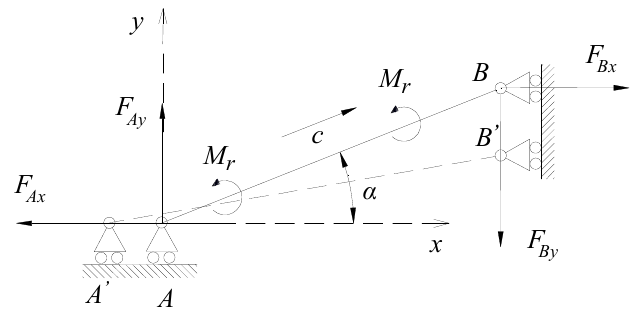
Figure 3. Single side deformation of the bridge amplifier.